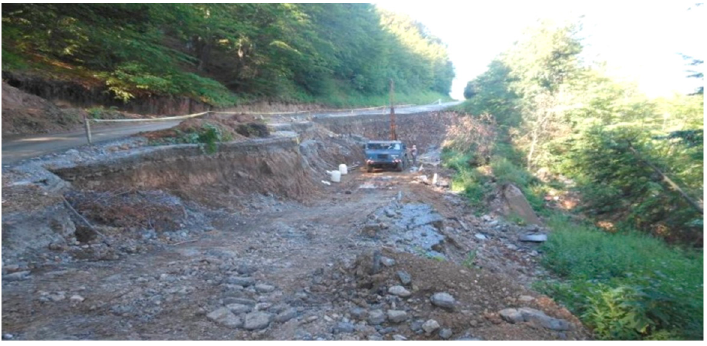
Figure 6. Formed slip on the part of the state road IIA-137 (P-127)